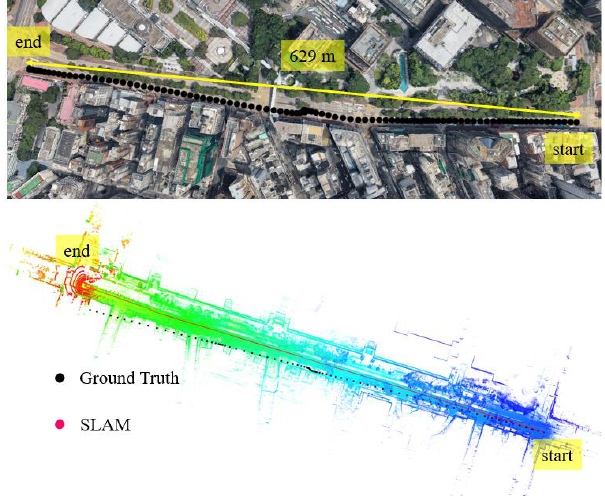
Figure 10. Experiment 3: the trajectory of NDT-based graph SLAM in a dense urban area with normal traffic condition. Top panel represents the snapshot in Google Maps. The black curve indicates the ground truth of the vehicle’s trajectory. The bottom panel indicates the generated points map and trajectory from SLAM.